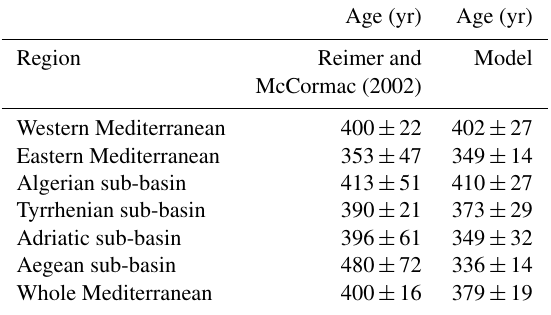
Table 1. Regional means of radiocarbon reservoir age before 1950AD. Column 2 gives the observations from (Reimer and Mc- Cormac, 2002), column 3 the model values in 1940AD. The uncer- tainty in the mean is the larger of the standard deviations based on counting statistics and the “standard deviation”, which is the square root of the variance. Age (yr) Age (yr) Reimer